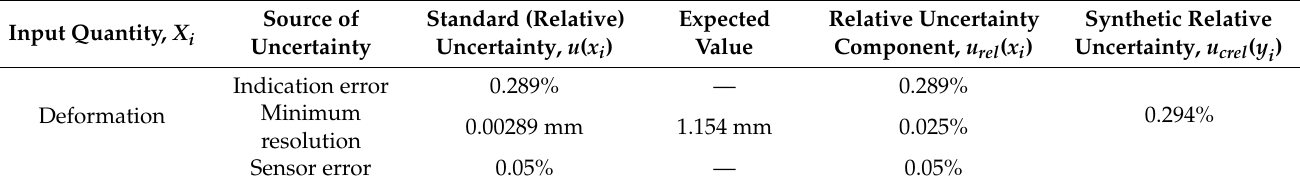
Table 2. Summary of uncertainty components of deformation.